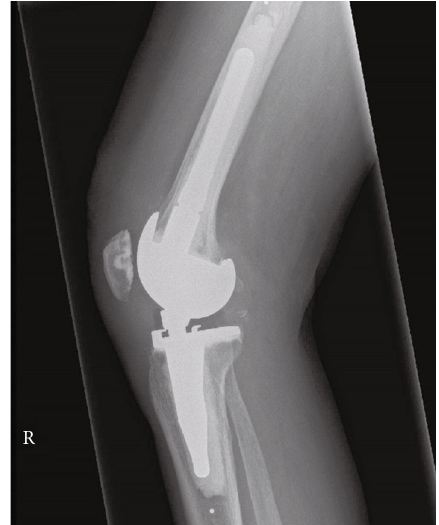
Figure 7: Postoperative radiographs showing the lateral view of the right